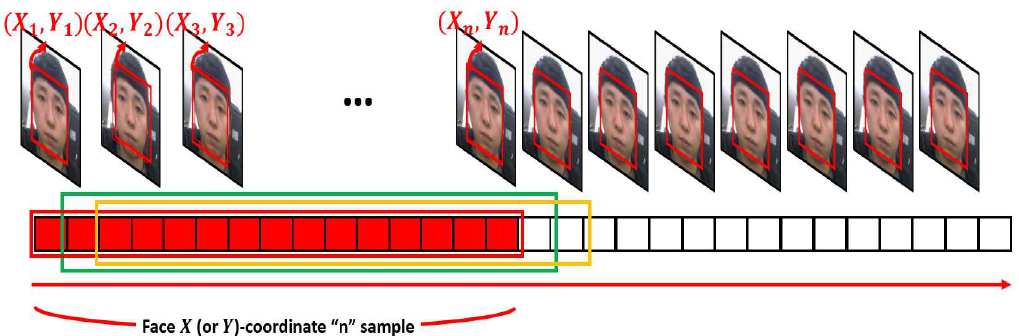
Figure 4. Example of n samples for facial X (or Y)-coordinates.